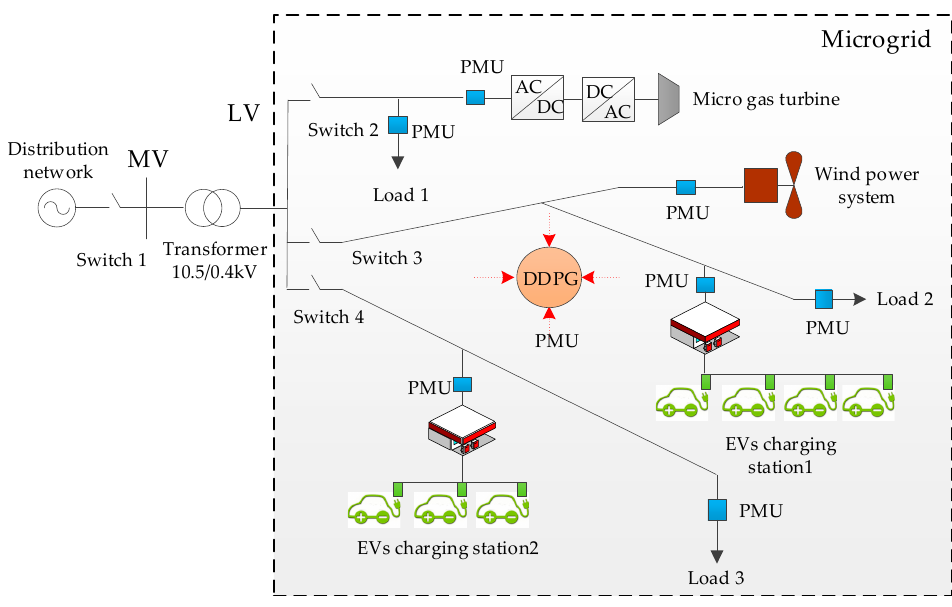
Figure 7. Microgrid LFC controller structure based on DDPG. Table 1. Parameters of equipment in microgrids.